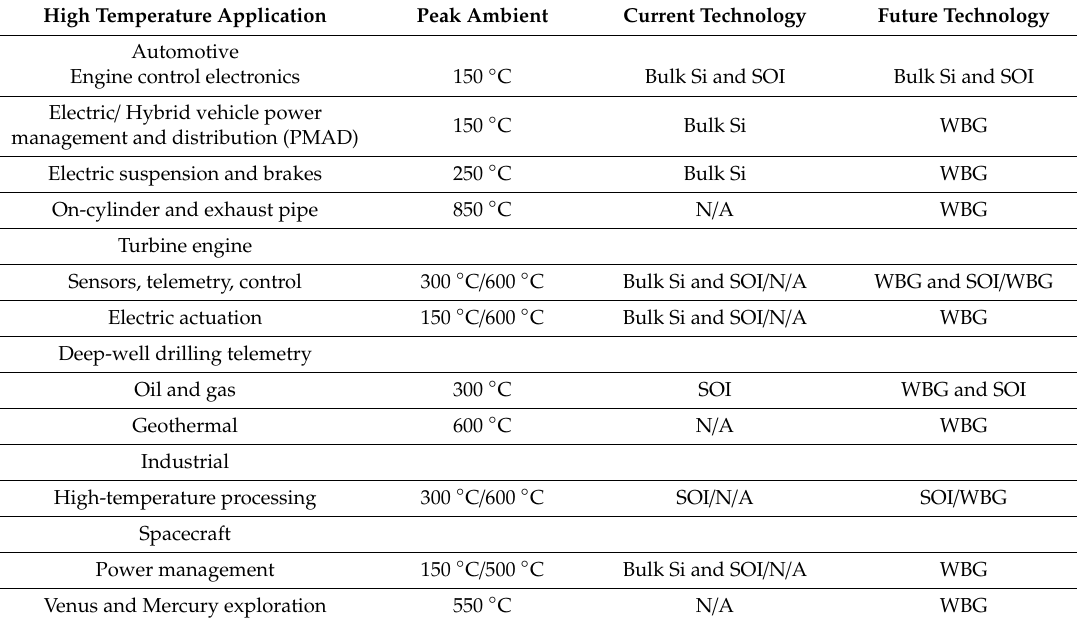
Table 1. Applications of high-temperature power